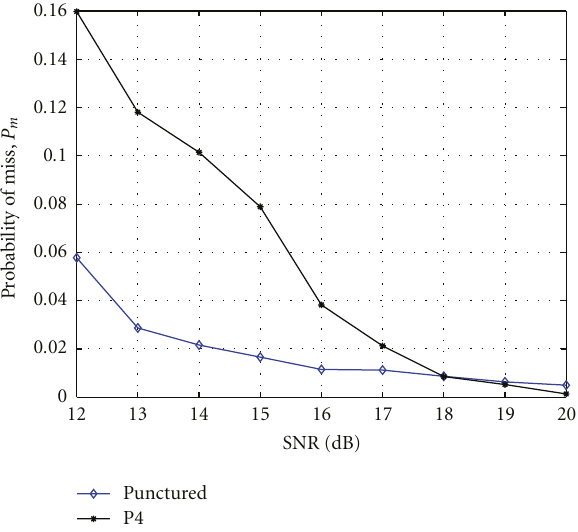
Figure 5: Probability of miss targets detection: 124-length opti- mized punctured ZCZ sequence-pair versus 124-length P4 code.